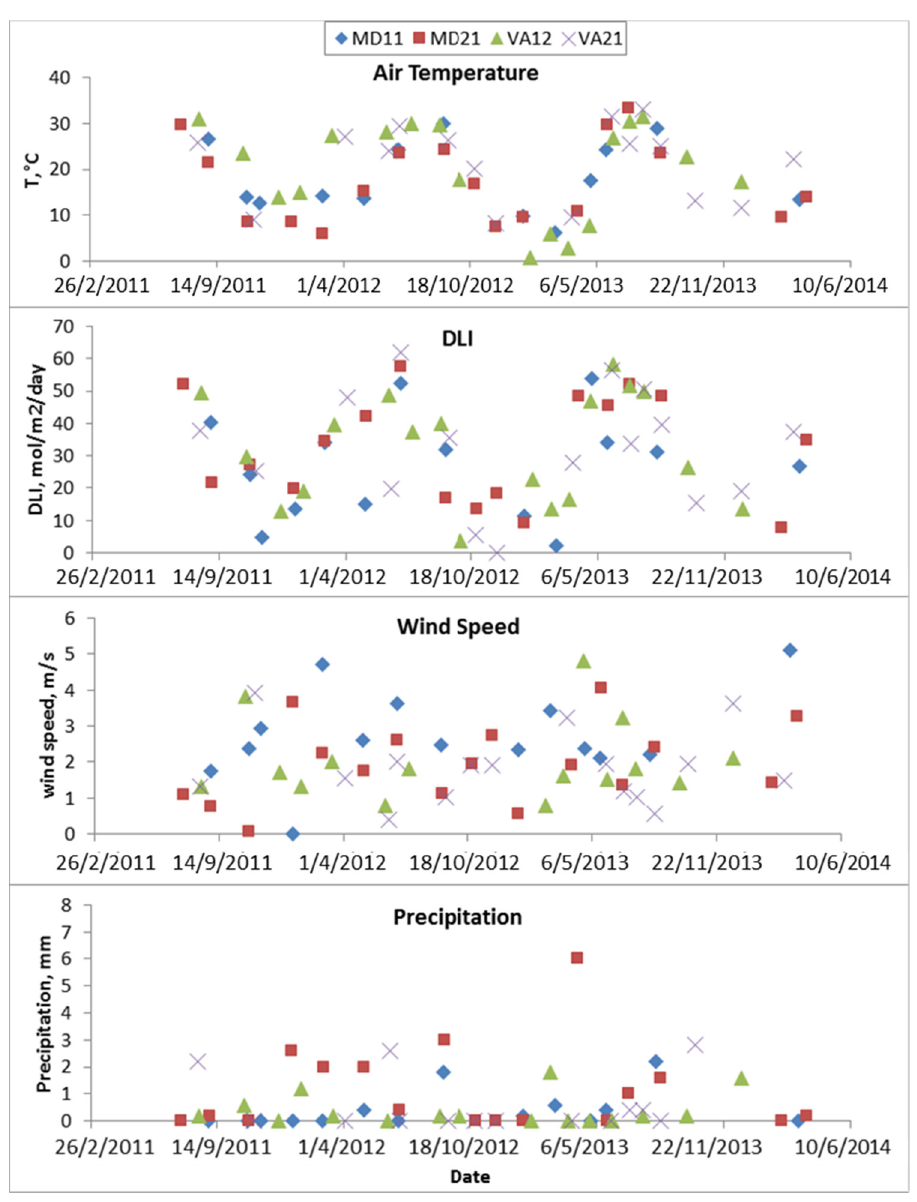
Figure 5. The daily average of air temperature, daily light integral (DLI), total precipitation and wind speed in VA reservoirs and MD reservoirs during the 2011 to 2014 study